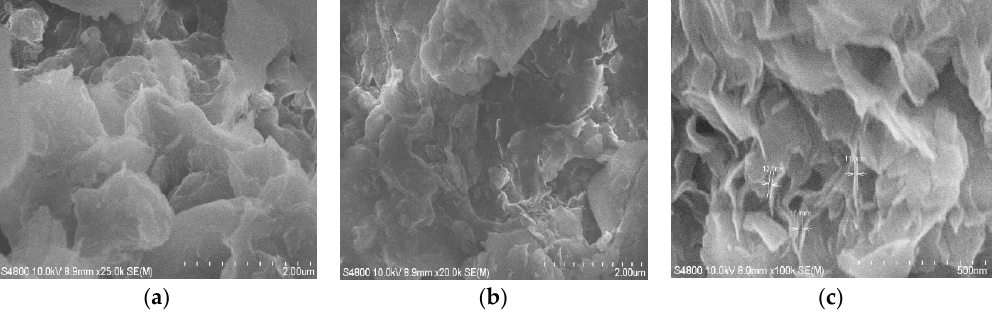
Figure 3. Scanning Electron Microscope (SEM) images of: ( a ) purified MT; and ( b , c ) LMT.